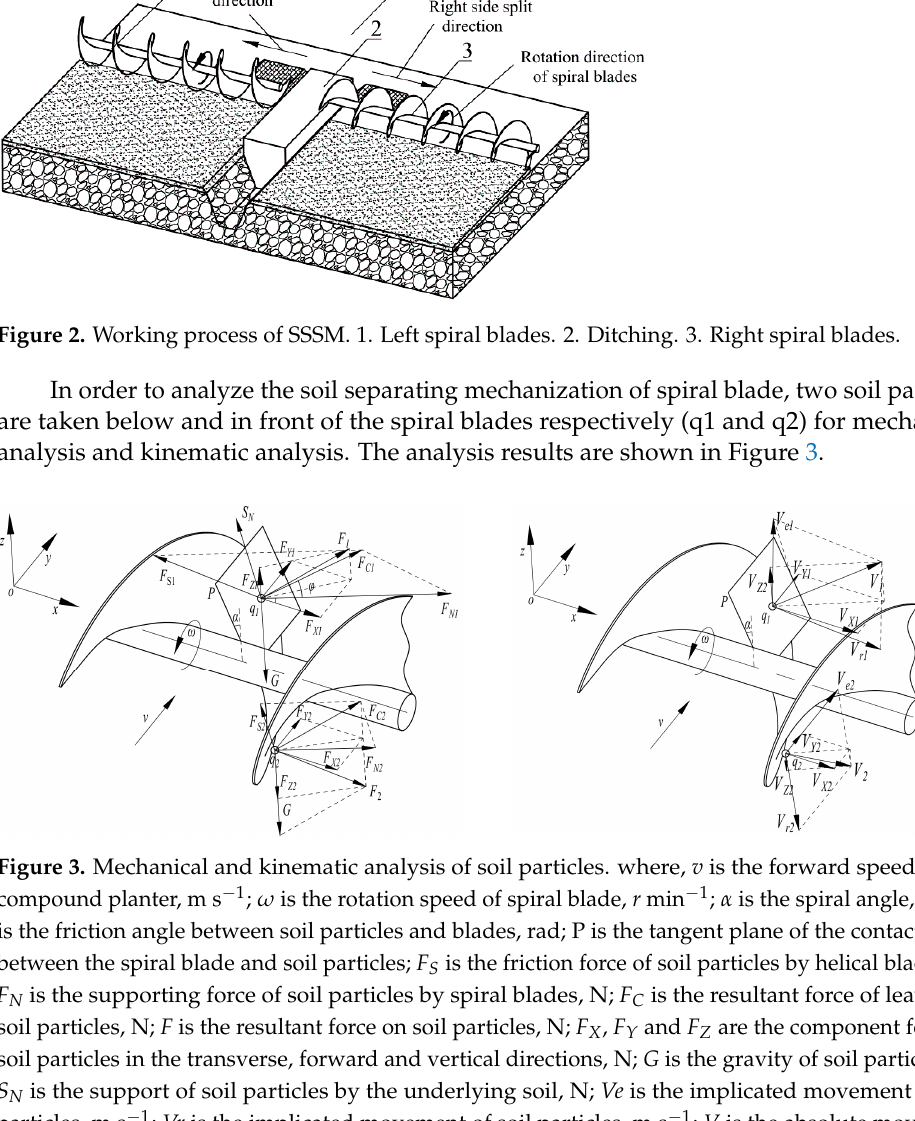
Figure 1. General structure of compound planter. 1. Biaxial rotary tillage mechanism. 2. Connect-